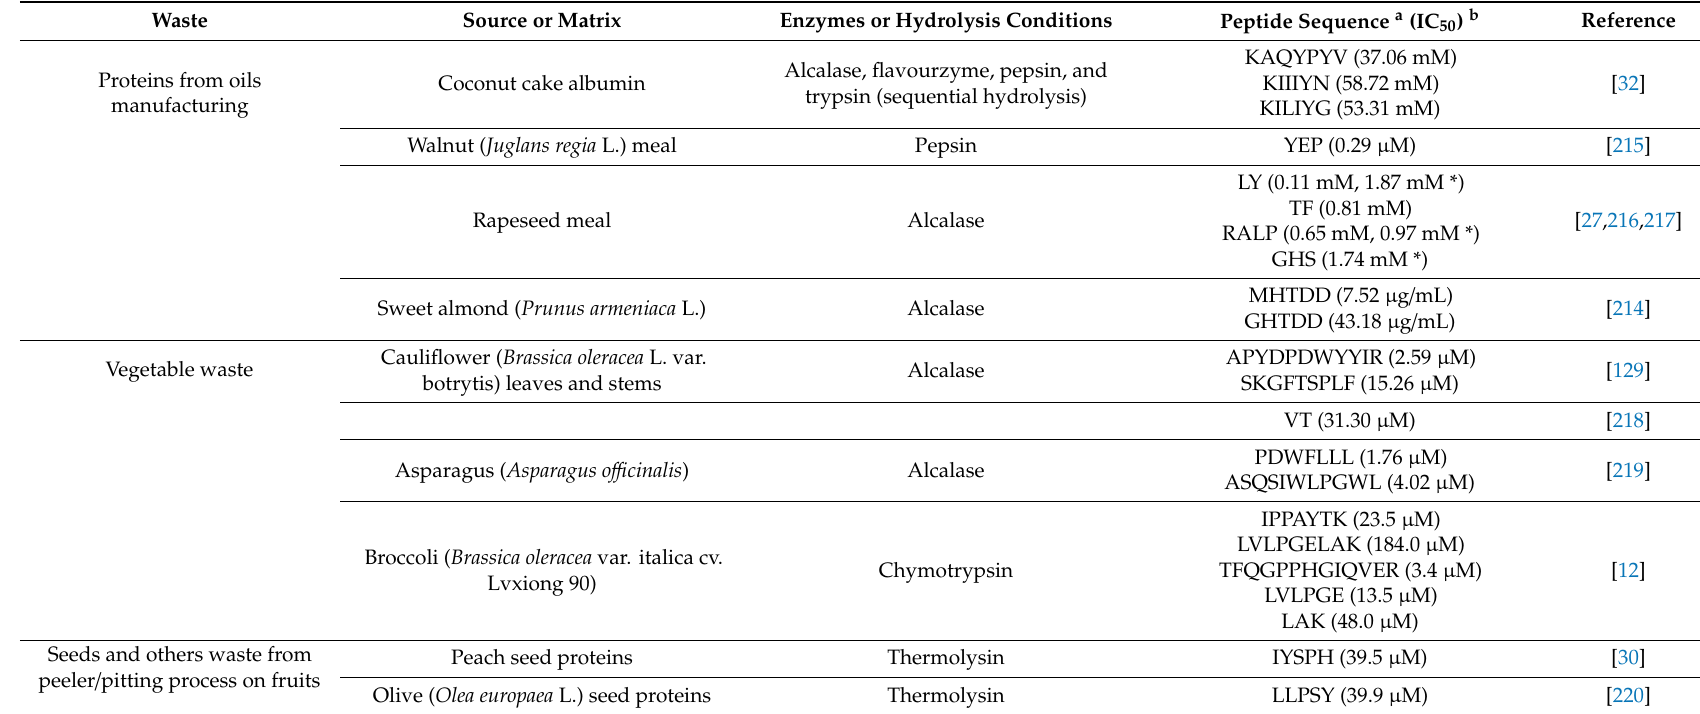
Table 5. Antihypertensive peptides obtained by enzymatic hydrolysis from waste of vegetable food